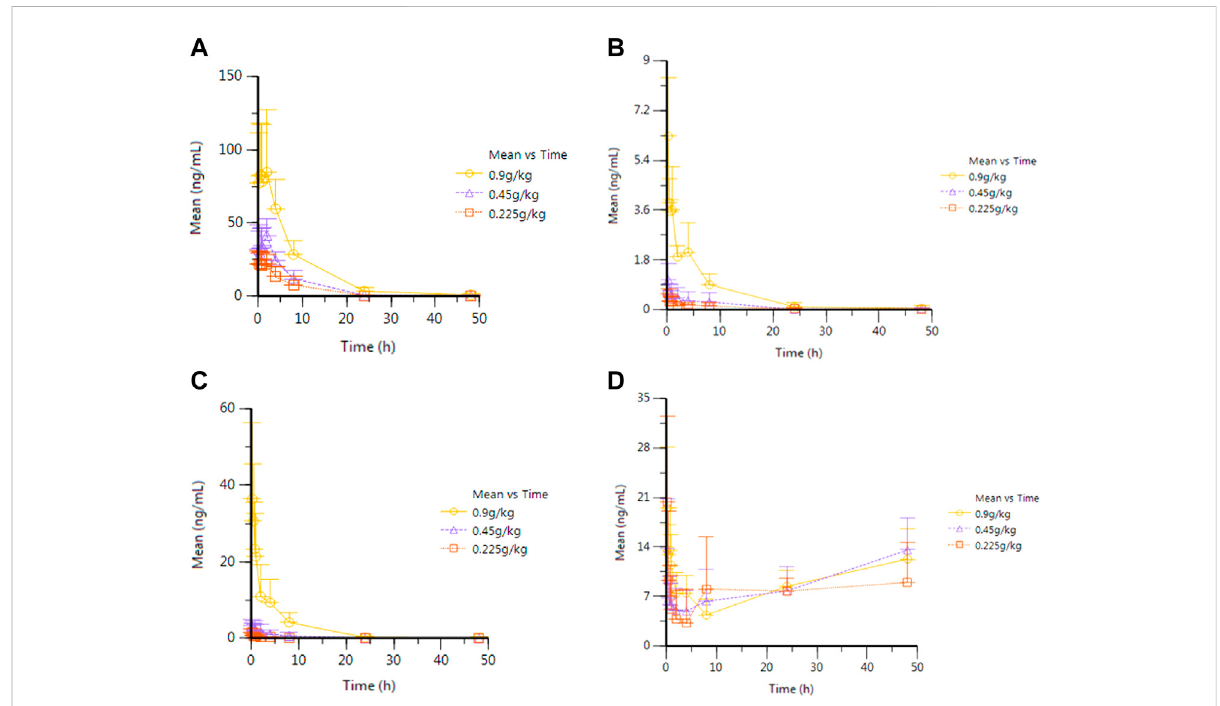
FIGURE 1 Average plasma concentration – time curve of eagleditol after different doses of RYZB. (A) Agarotetrol; (B) isoliquiritigenin; (C) piperine; (D) ferulic